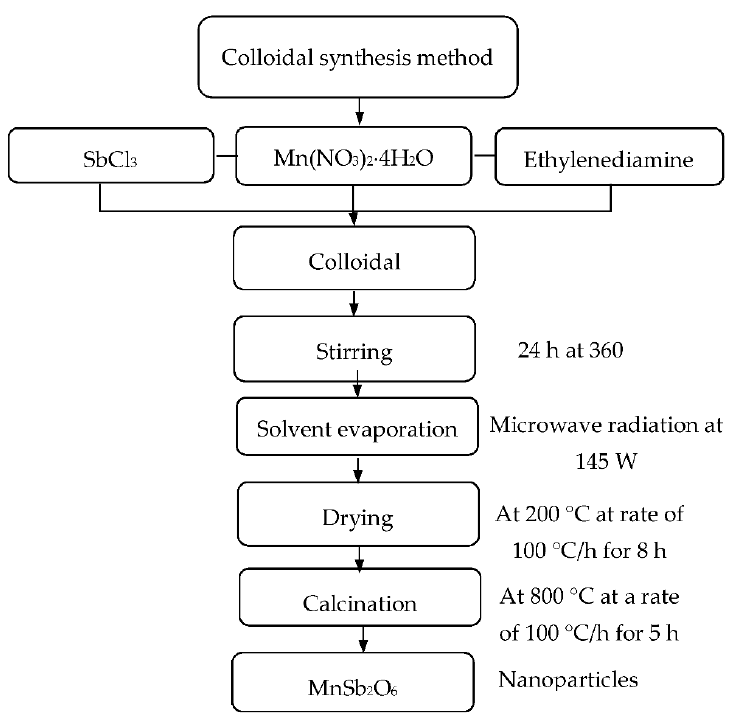
Figure 1. Synthesis process of the manganese antimonate nanoparticles.